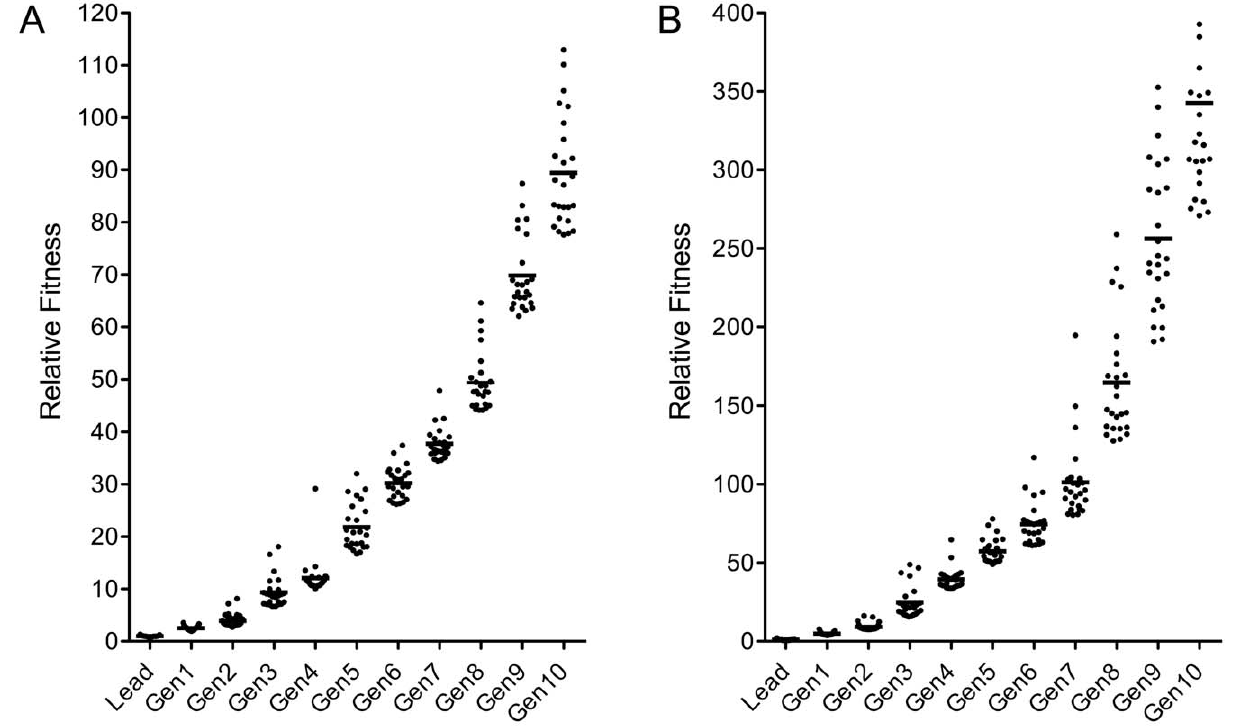
Figure 4. Increase in target-binding strength of peptide sequences in the course of the molecular evolution process. A. L-peptides B. D-peptides. The relative fitness (compared to the lead peptides) of the 25 best lysoG M1 /Dy650 binding peptides from each generation is shown. Horizontal bars indicate the arithmetic mean of the 25 best fitness values of each generation.